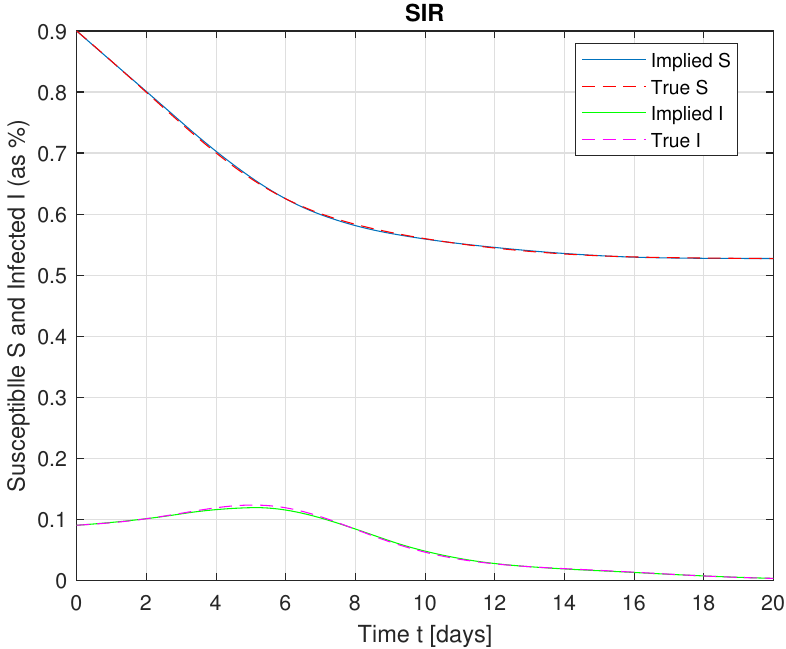
Figure 5. Recovered susceptible S and infected I population with